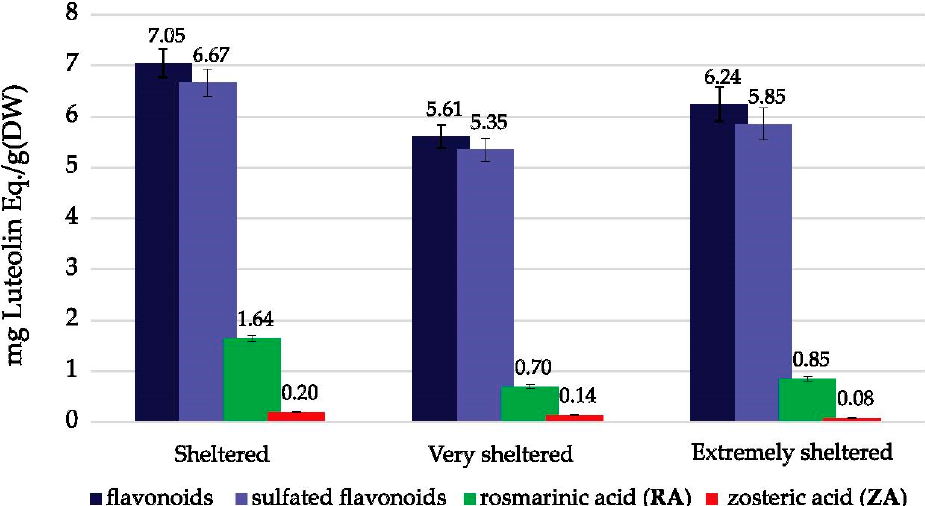
Figure 5. Average values of total flavonoids (TF), total sulfated flavonoids (TSF), rosmarinic acid (RA) and zosteric acid (ZA) content for the 24 Zostera marina samples in the dataset (A-N, see Section 4.1).